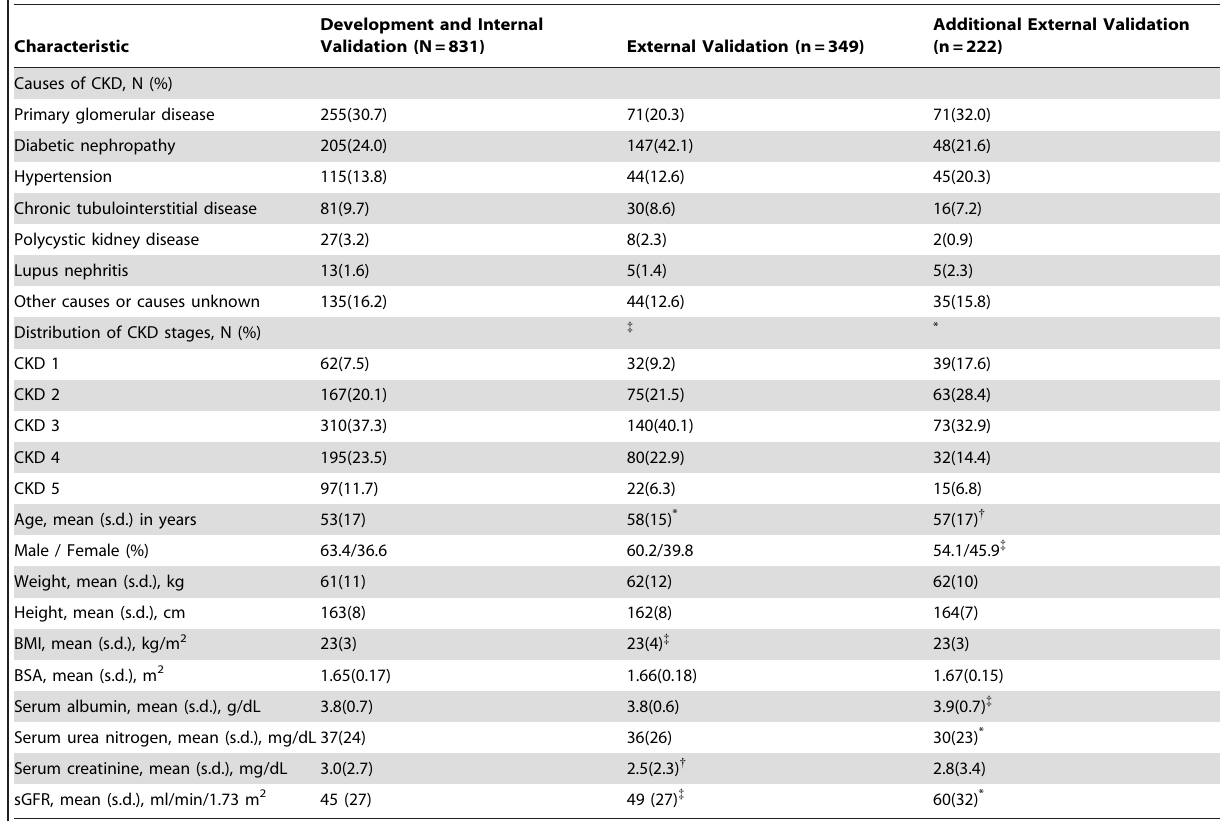
Table 1. Patient